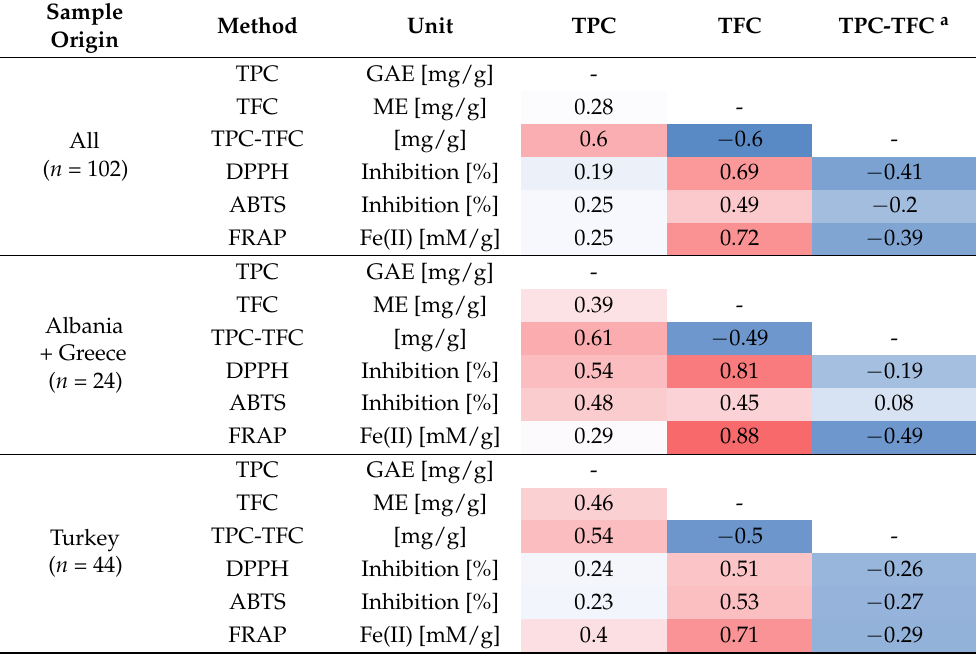
Table 6. Correlation between chemical composition and antioxidant effect (as